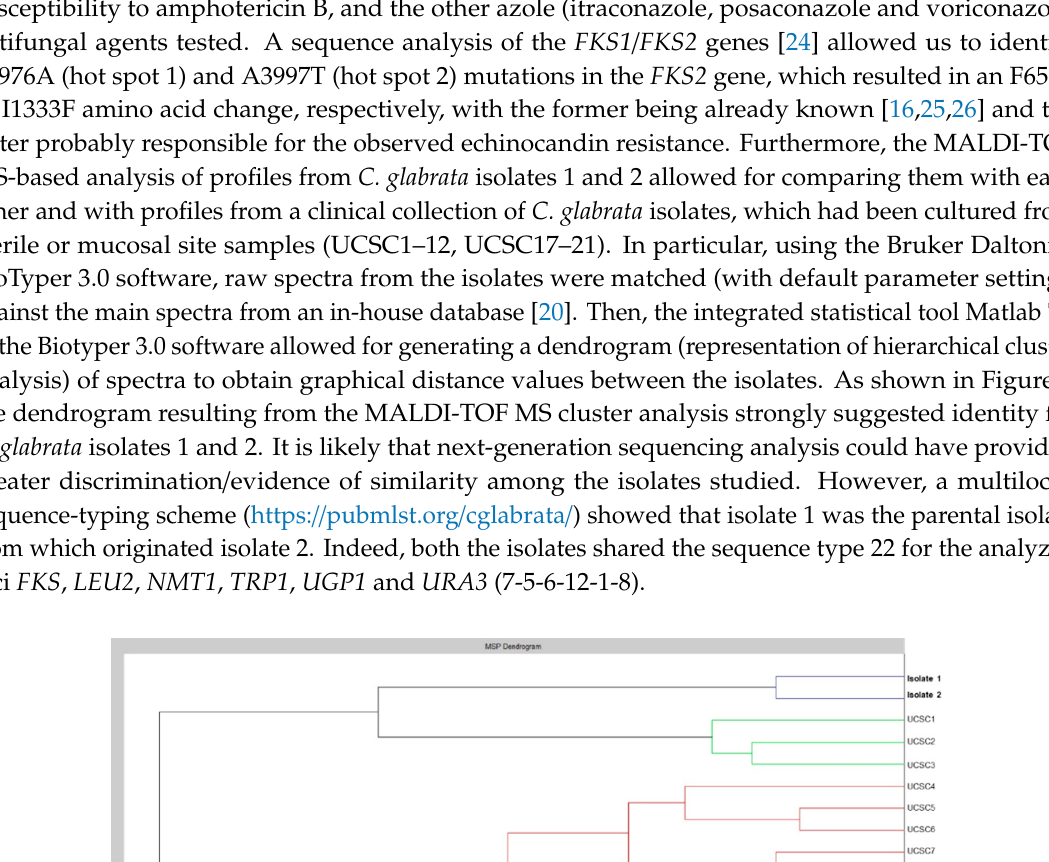
Figure 2. Timeline of major microbiological events during the patient’s clinical course and relative antimicrobial treatments. Fever (solid line) or procalcitonin (dashed line) patterns are shown.